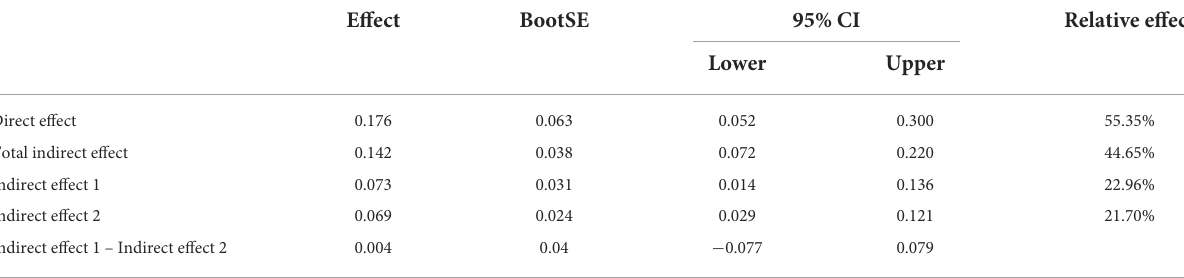
TABLE 4 Multiple mediating paths between social support and parenting sense of